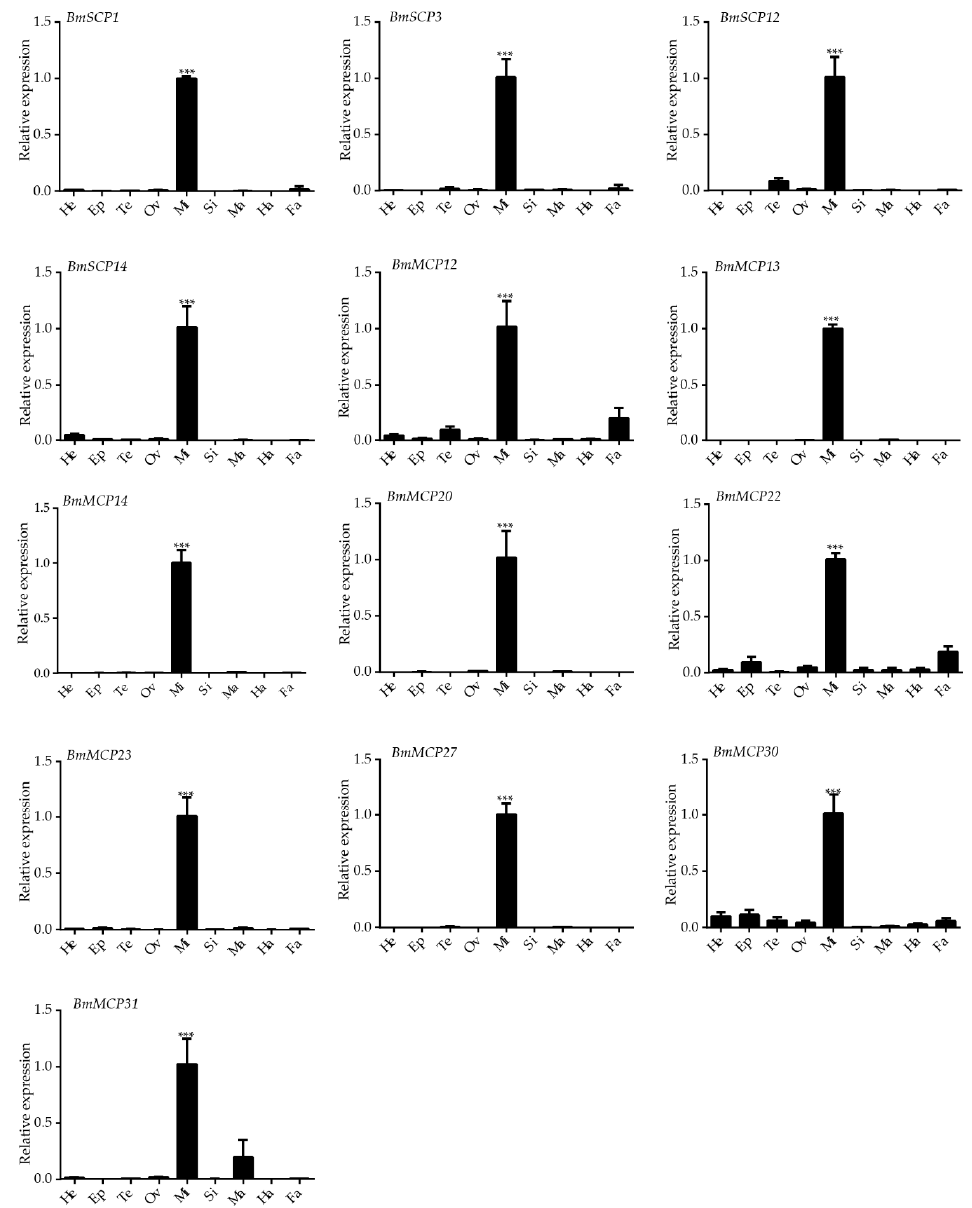
Figure 3. Expression patterns of midgut-specific carboxypeptidases at Day 3 of the fifth instar.